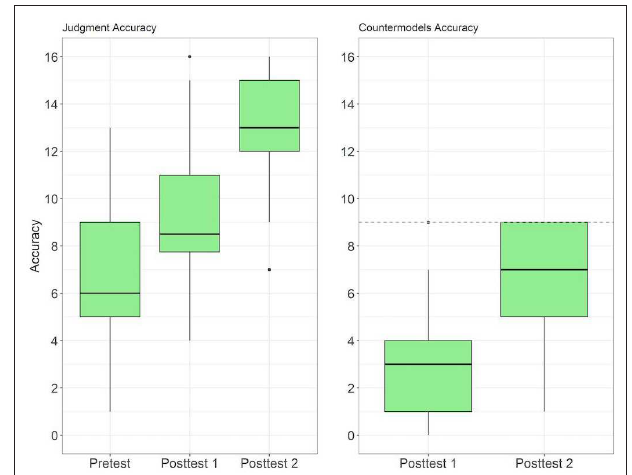
FIGURE 8 | Boxplots showing the subjects’ performance distribution in the three stages of Experiment 2. Left: performance in problems evaluation. Right: performance in correct countermodel construction in the two last